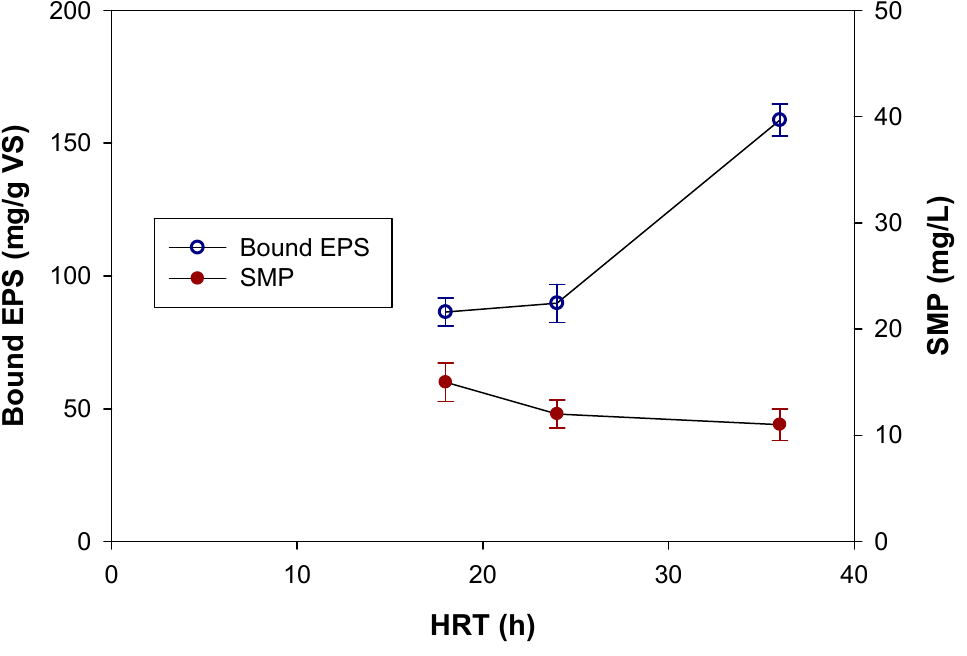
Figure 8. SMP and bound EPS in mixed liquor.